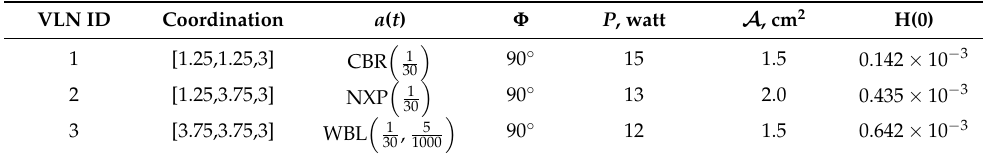
Table 4. Key parameters of simulation